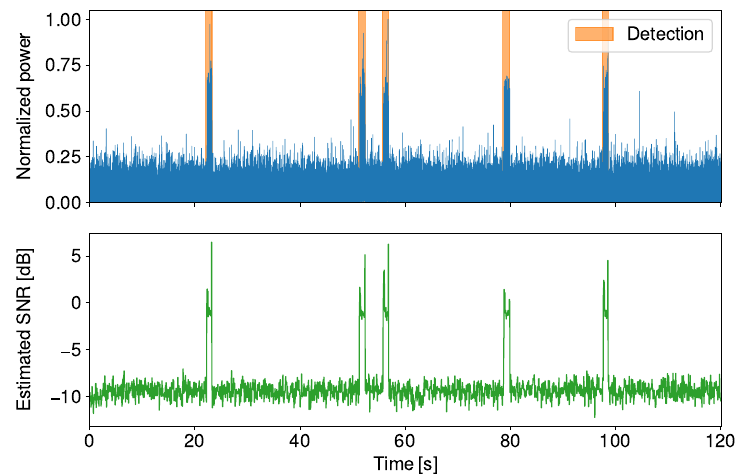
Figure 4. Normalized power, detected bands and estimated SNR of an APRS signal